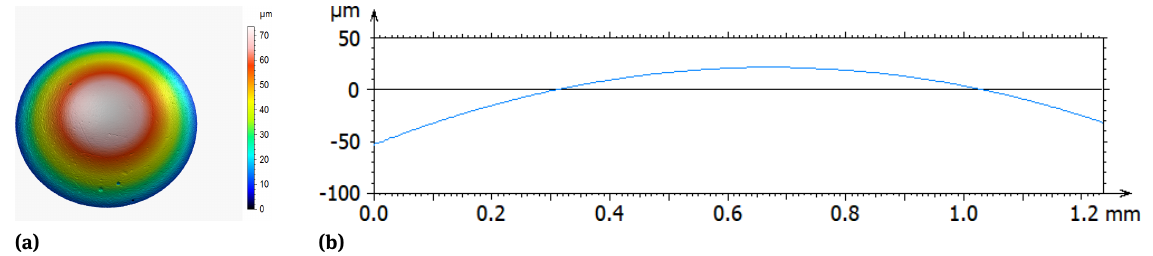
Figure 4: Geometric structure of 100Cr6 steel ball with the a–C:H coating: a) isometic image, b) primary profile.